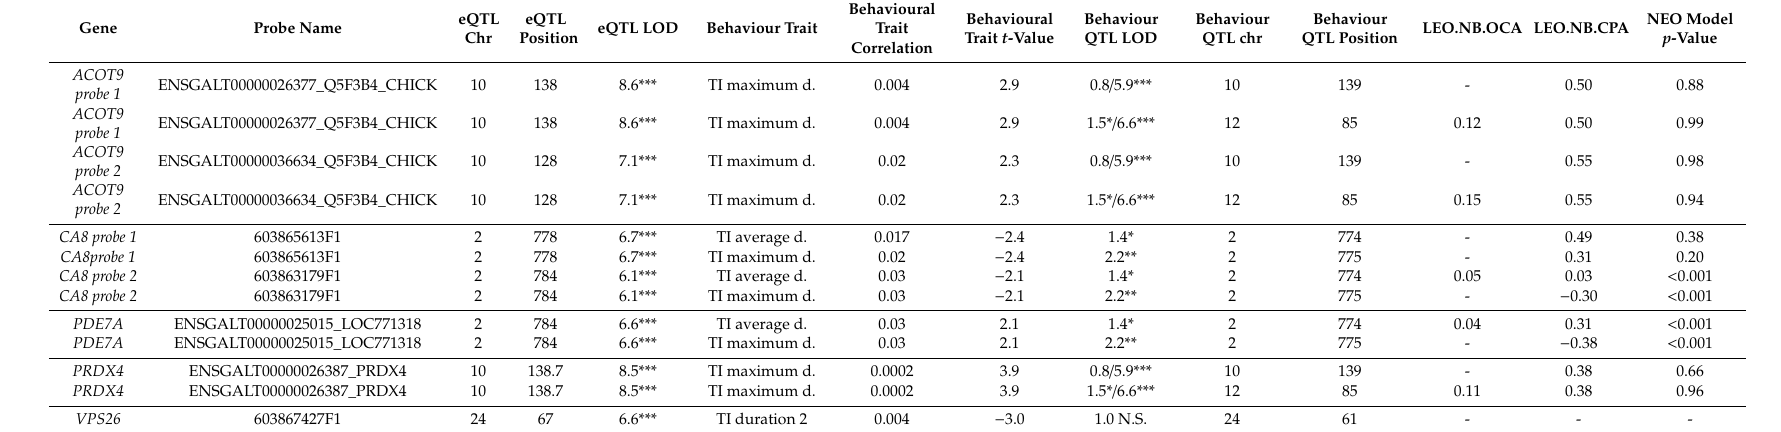
Table 2. Causality analysis of the candidate genes in the eQTL sub-population of the F 8 mapping population. Gene and probe name (in the microarray) are provided, as are the eQTL chromosomal location and position in cM. The p -value of the correlation with the behavioural trait, as well as which behavioural trait is also included. The QTL e ff ect of the behaviour specifically in the eQTL sub-population is included, to allow the behavioural QTL strength of e ff ect in this smaller sub-population to be assessed (* p < 0.05, ** p < 0.01, *** p < 0.001). Where two values are given the first is the significance of the behavioural QTL with just the single marker e ff ect, the second is with the two marker epistatic interaction detected in the full sample included. Causality metrics leo.nb.oca and leo.nb.cpa measures are used to assess the strength of causality, with leo.nb.cpa values used when eQTL and QTL share the same genetic marker and leo.nb.oca values are used when eQTL and behavioural QTL have separate